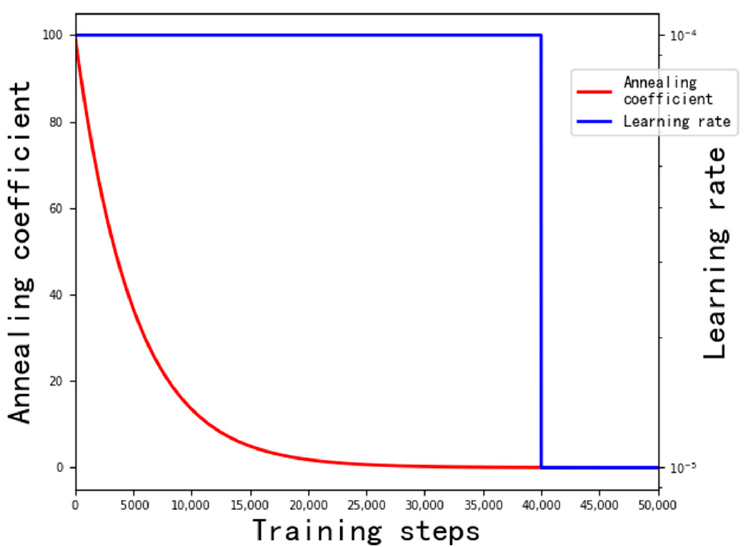
Figure 7. Relationship between the number of training steps and the coefficient of the annealing term and the learning rate.